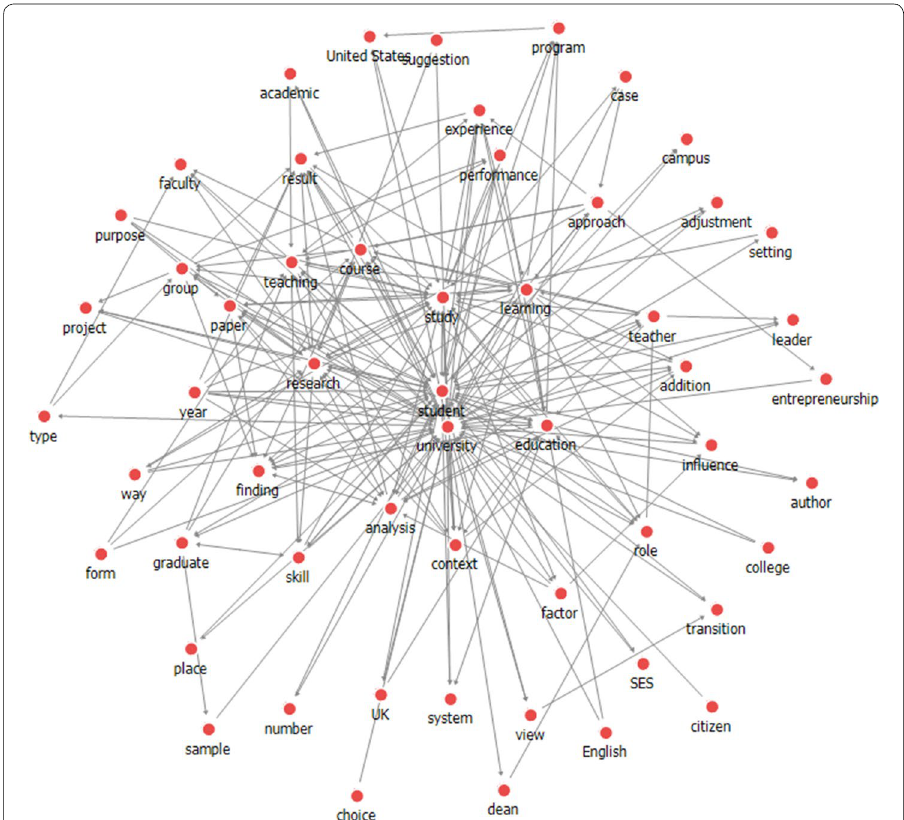
Fig. 4 The detailed layout view of network